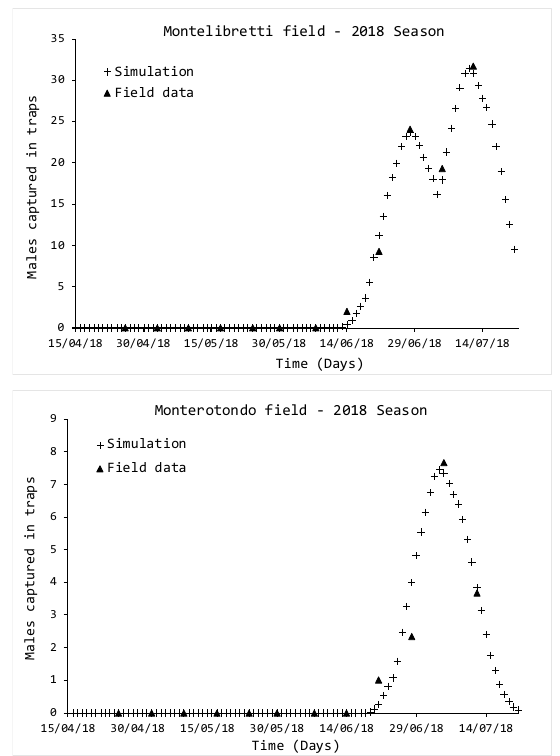
Figure 3. Comparison between simulated and monitored D. suzukii populations, growing season 2018. Triangle indicators represent data from traps, while crosses indicate simulations. Insects 2020 , 11 , x FOR PEER REVIEW